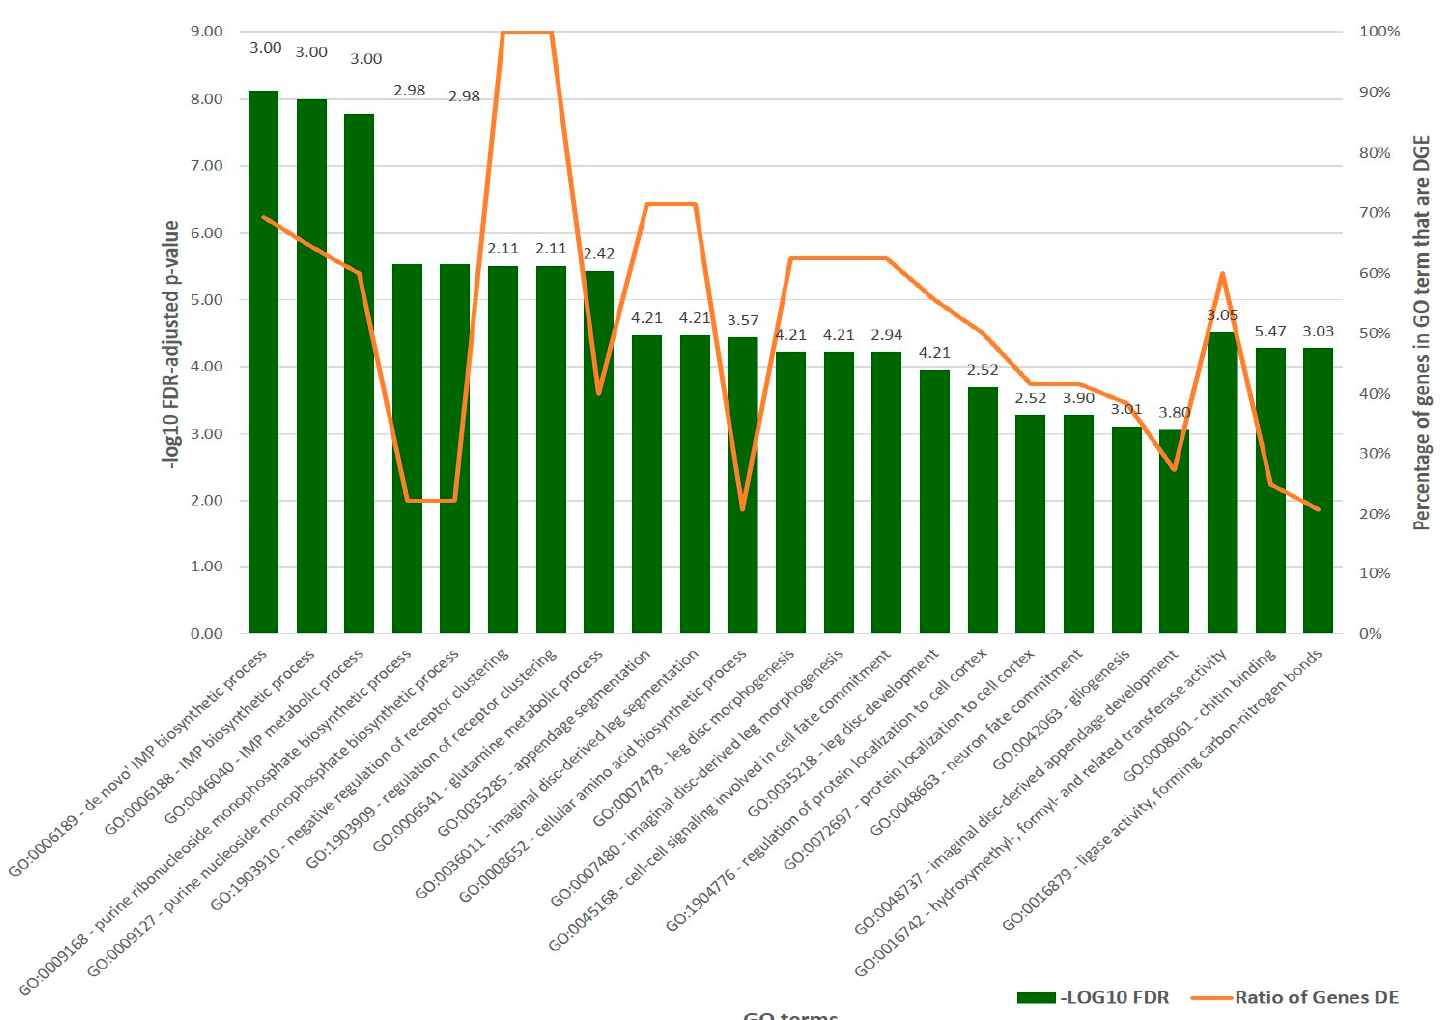
Figure 4. Significant GO terms for differentially expressed genes (DEGs) between vaccinated and non-treated control groups. The mean logFC measured using DeSeq2 is shown for each GO classification above each bar.